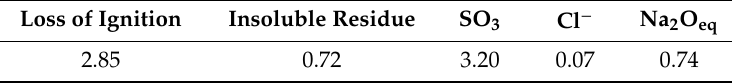
Table 4. Chemical properties of cement CEM I 42.5 R as (%)